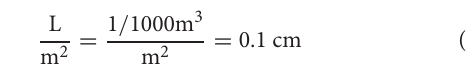
albedo aging model (Riley et al., 1969) was used, with t as the sole